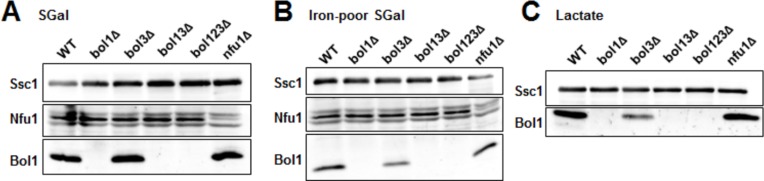
Late ISC protein levels in various yeast strains.Wild-type (WT; BY4742), indicated BOL deletion strains and nfu1Δ cells were grown in (A) minimal medium containing 2% galactose supplemented with 50 µM ferric ammonium citrate, (B) iron-poor minimal medium containing 2% galactose or (C) lactate medium. Mitochondria were isolated and the indicated protein levels were determined by immunostaining. The Hsp70 protein Ssc1 served as a loading control. As shown below (Author response image 2), wild-type levels of Bol3 were not detectable by our antibody precluding analysis of this protein.